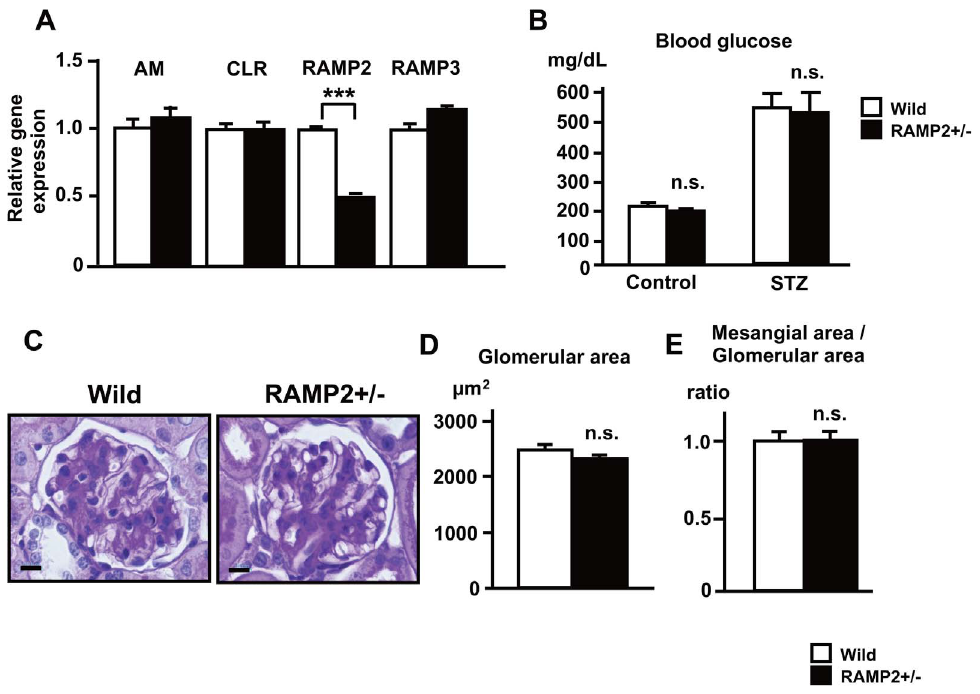
Figure 1. Blood glucose and glomerular changes in the STZ-induced diabetic nephropathy model. (A) Bar graphs showing relative gene expression determined by quantitative real-time PCR. Gene expression of RAMP2 was downregulated in RAMP2 + / 2 kidney. (B) Effect of STZ treatment on blood glucose levels. In both the control and STZ groups, blood glucose levels did not differ between wild-type and RAMP2 + / 2 mice 2 weeks after STZ administration. Data were obtained at 10:00 a.m. without fasting. (C-E) Comparison of glomerular lesions in wild-type and RAMP2 + / 2 kidneys following STZ treatment. (C) PAS staining of glomeruli 12 weeks after STZ administration. Scale bars=10 m m. (D) Glomerular area. (E) Mesangial area/glomerular area ratios. n=5 in each group. Bars are means 6 SEM. ***p , 0.001. n.s.=not significant.